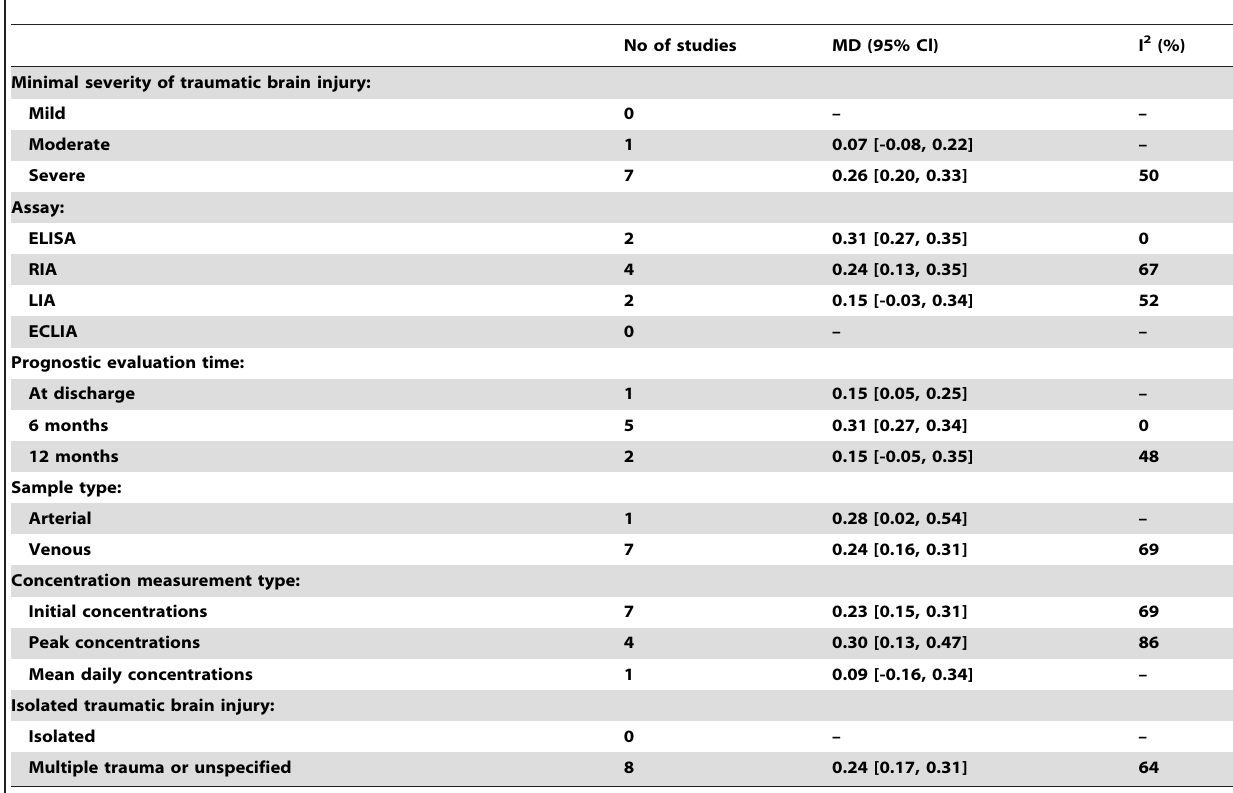
Table 3. Sensitivity analyses for association of NSE concentrations with unfavourable outcome in patients with traumatic brain injury.